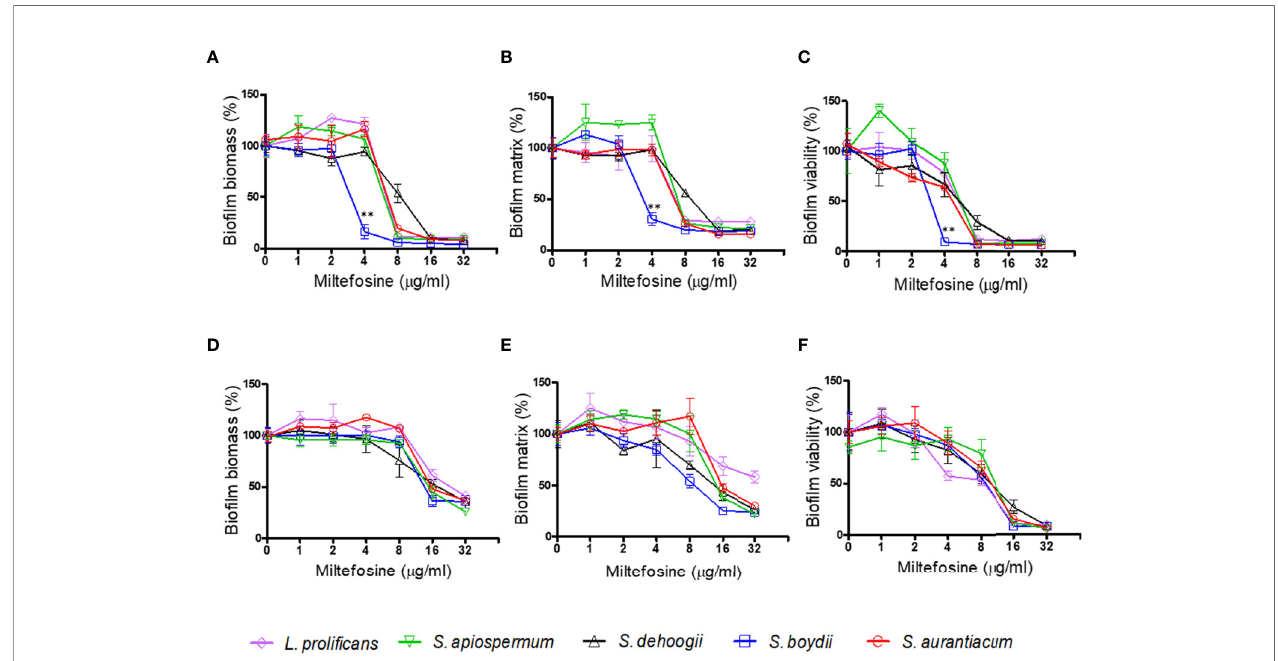
FIGURE 3 | The effect of miltefosine on bio fi lm formation (A – C) and preformed bio fi lm (D – F) of Scedosporium aurantiacum , Scedosporium boydii , Scedosporium apiospermum , Scedosporium dehoogii and Lomentospora proli fi cans . The fungal biomass was measured by crystal violet (A, D) , the extracellular matrix was measured by safranin (B, E) and metabolic viability was evaluated by the XTT-reduction assay (C, F) . ** p < 0.01.